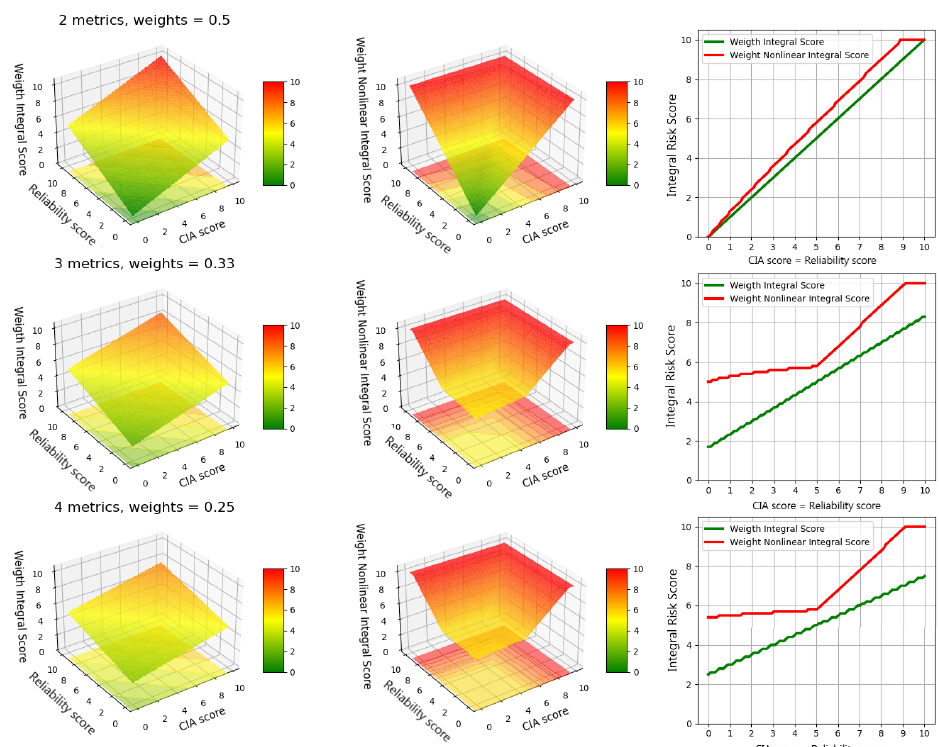
Figure 3. Integral risk score values using a weighting algorithm and using the proposed nonlinear weighting algorithm. The rows show calculations for a different number of